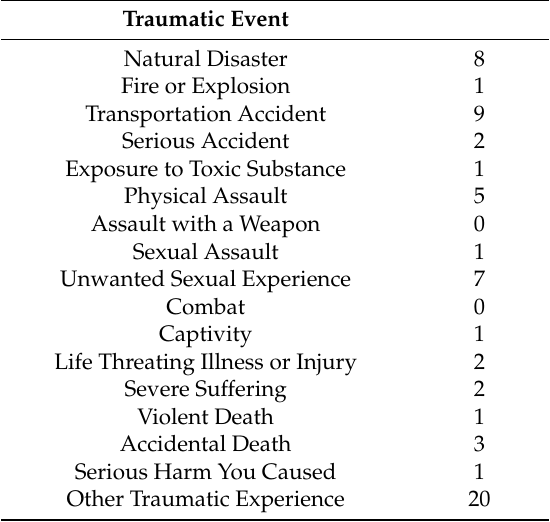
Table 1. Frequency of intervening traumatic